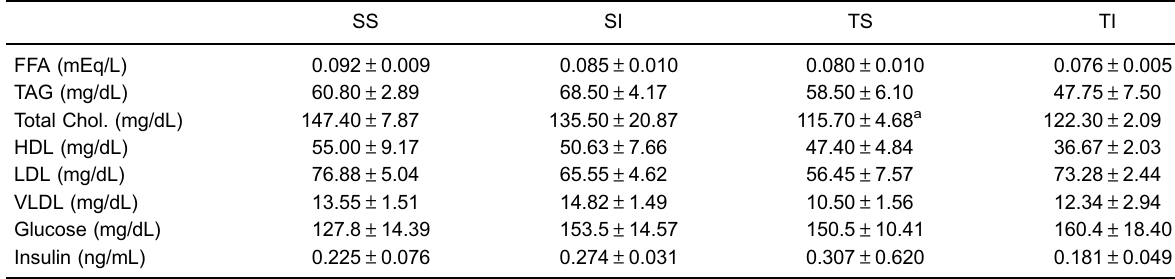
Figure 2. Representative histological sections of gastrocnemius muscle ( A ) and peritoneal adipose tissue ( B ) of Swiss mice of groups SS: sedentary treated with saline; SI: sedentary treated with insulin; TS: trained treated with saline; and TI: trained treated with insulin. Hematoxylin-eosin staining. Table 2. Plasmatic parameters of Swiss mice of groups SS: sedentary treated with saline; SI: sedentary treated with insulin; TS: trained treated with saline; and TI: trained treated with